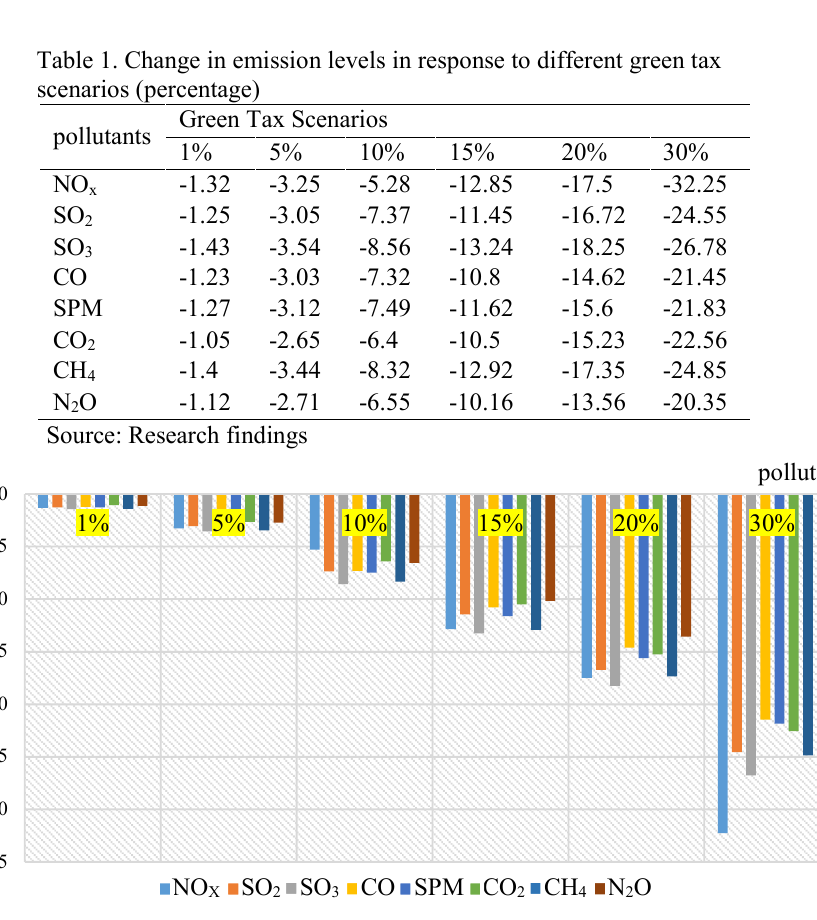
Fig. 1. Change in emission levels in response to different green tax